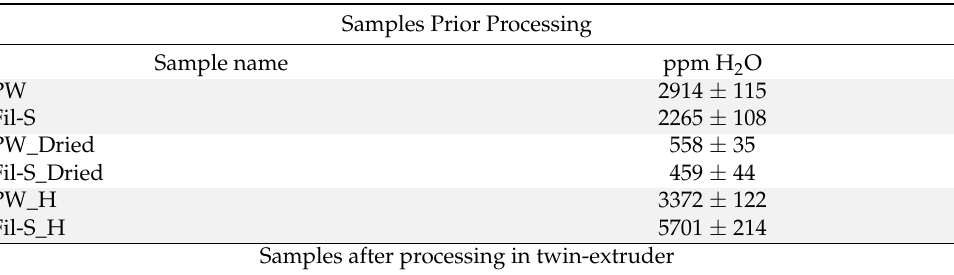
Table 1. Samples’ nomenclature and description.